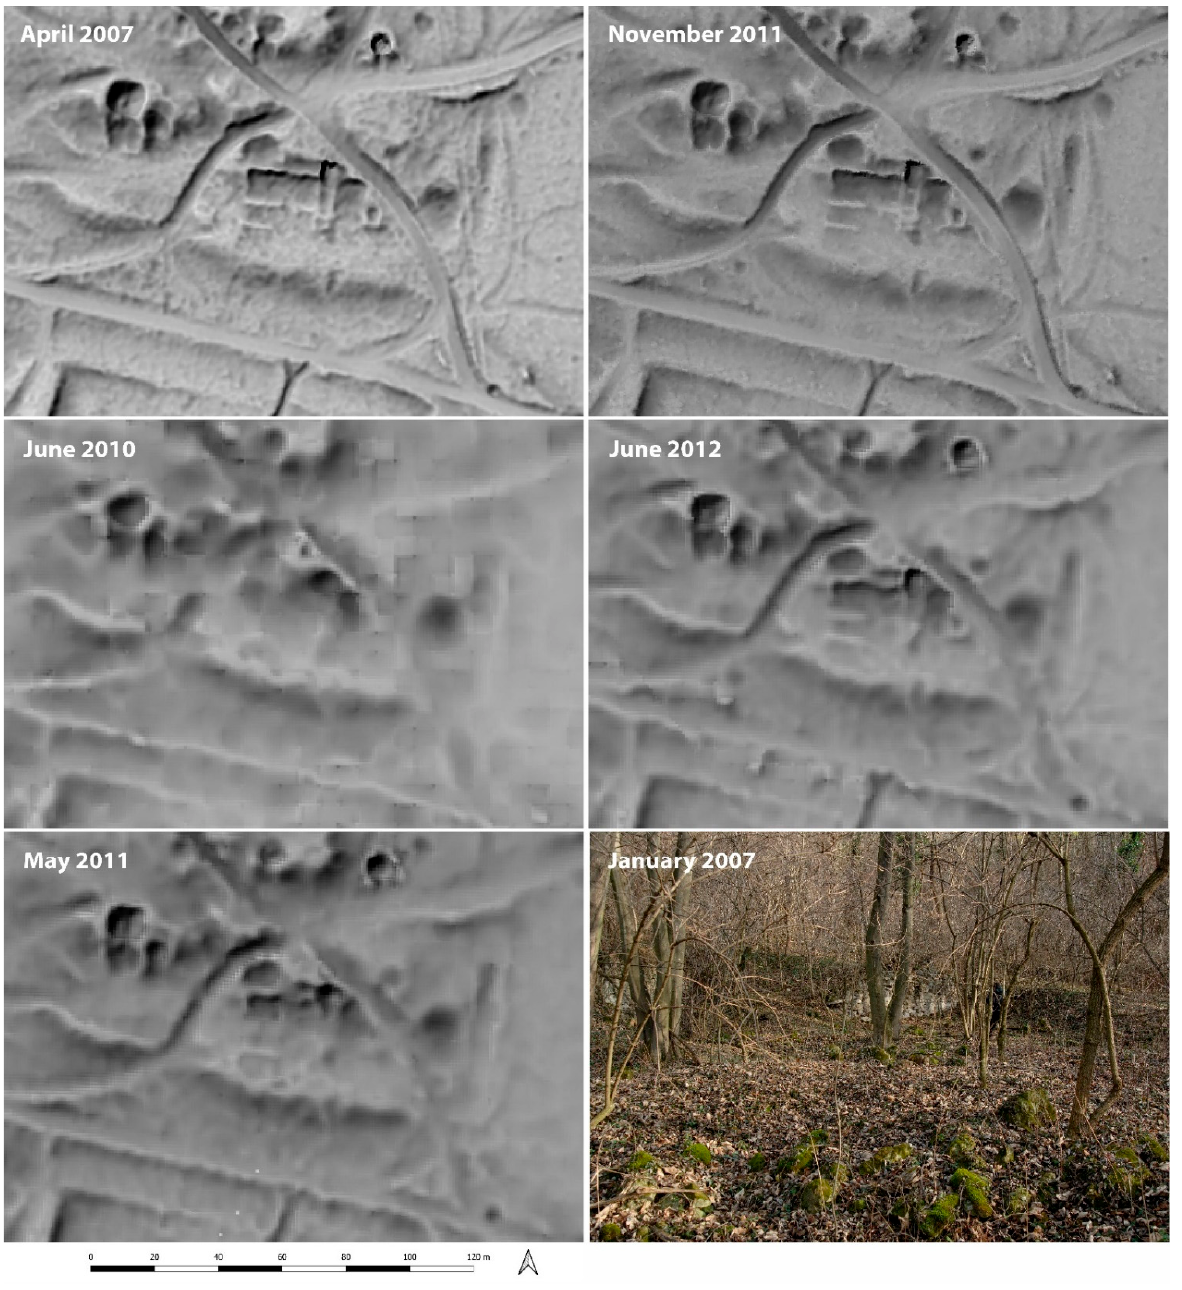
Figure 18. Sample zone from Area 1 displaying a ruined farm building. All visualizations are a combination of positive openness (with colour gradient black to white, stretch to min–max, min.